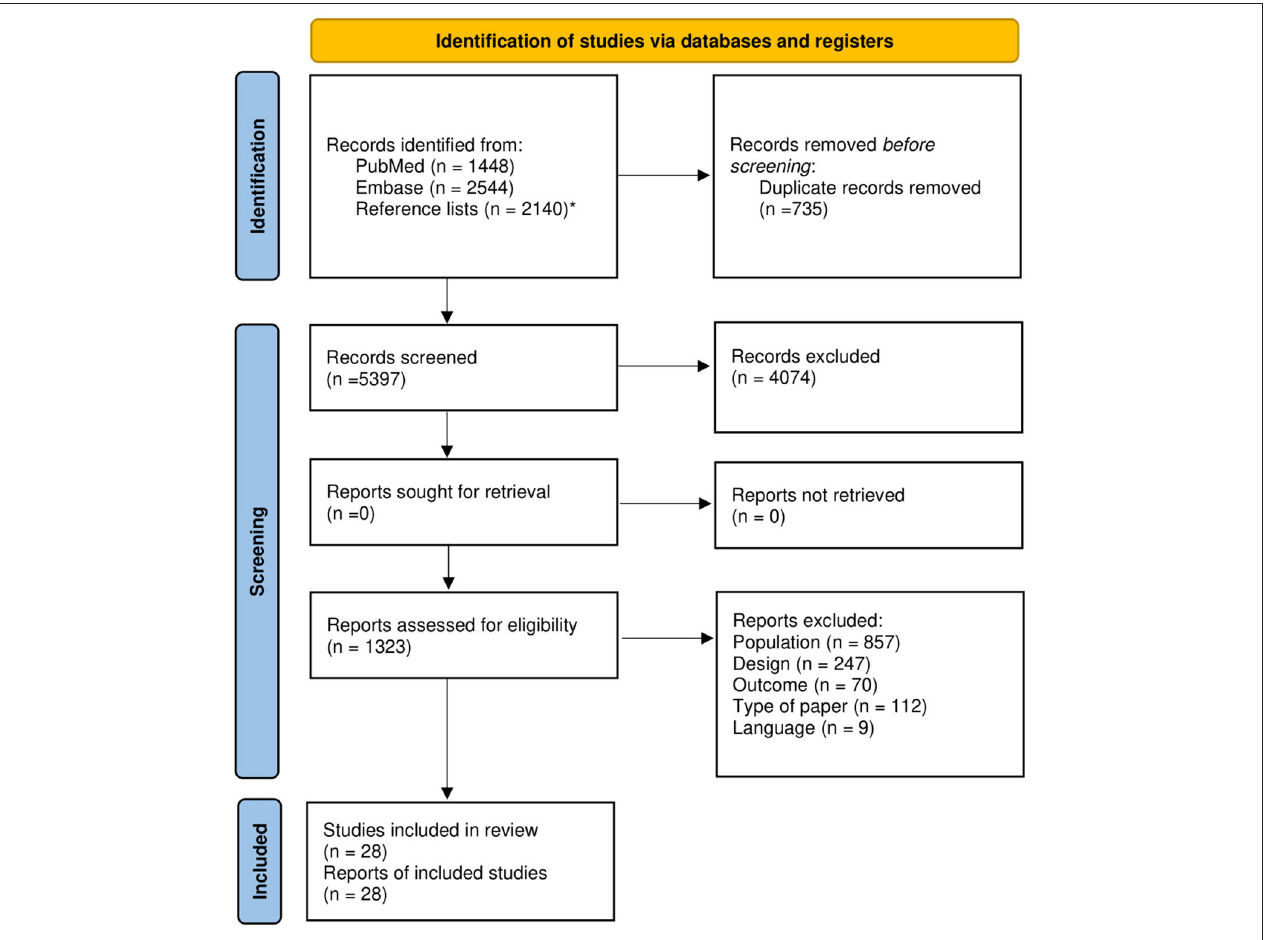
FIGURE 1 | Flow-chart of study selection for systematic reviewing and meta-analysis. *The reference lists from the included full-text studies were also screened on title, abstract and full text.